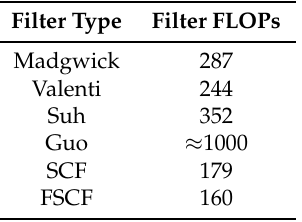
Table 4. The computational cost for each filter in terms of floating-point